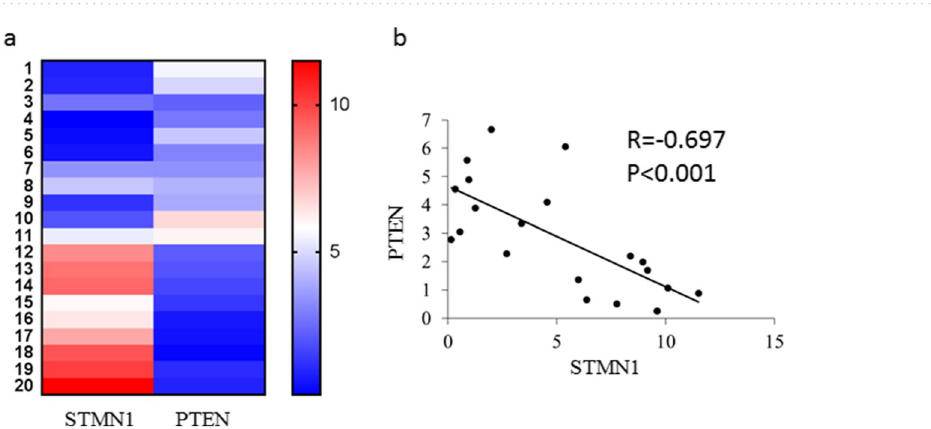
Figure 6. Expression of STMN1 and PTEN in lung cancer specimens. ( a ) Real time PCR was used to detect the mRNA level of STM1 and PTEN in lung cancer specimens. ( b ) The correlation between STMN1 and PTEN expression level in lung cancer specimens was